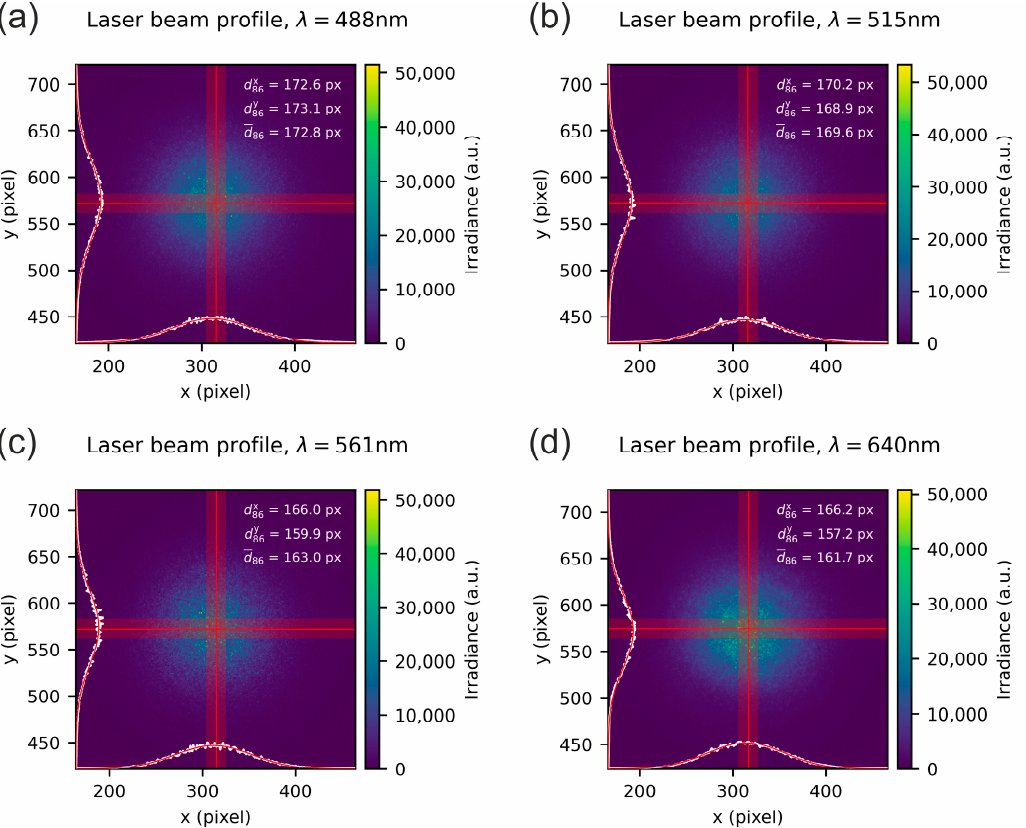
Figure A2. Irradiance distribution of the laser beam at the viewing screen for laser wavelengths of ( a ) 488 nm, ( b ) 515 nm, ( c ) 561 nm and ( d ) 640 nm. Additionally, vertical and horizontal profile lines through the centroid of the irradiance distribution are shown.